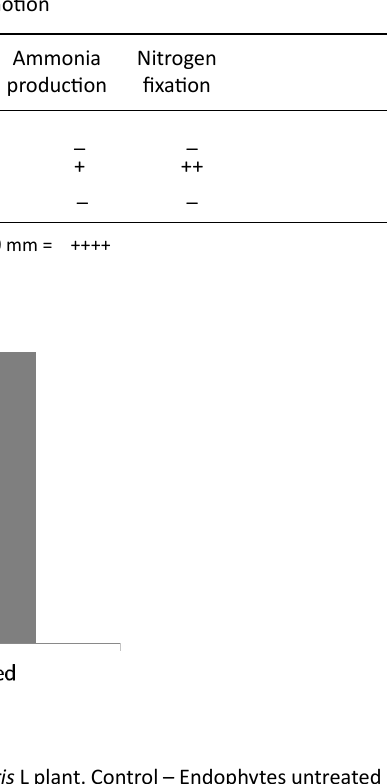
Fig. 4. Effect of FRR2 endophyte on DPPH activity of A. campestris L plant. Control – Endophytes untreated plants; Treated – Endophytes treated